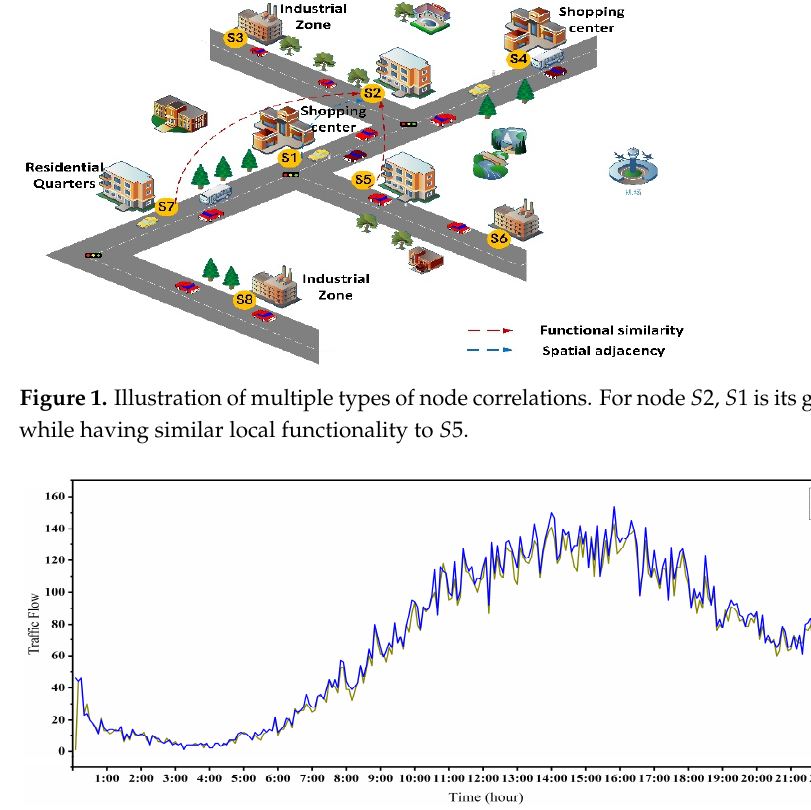
Figure 2. Example illustrating traffic flow correlation in functionally similar areas. Traffic flows at nodes 𝑆2 and 𝑆5 during the same period.